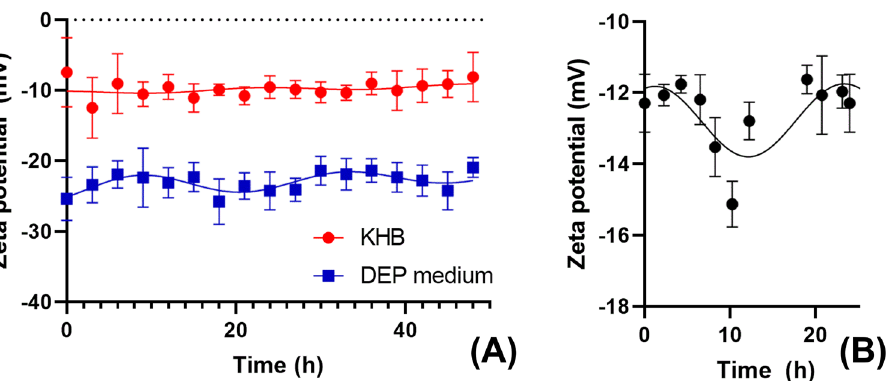
Figure 6. Circadian behaviour of ζ -potential in RBCs. ( A ) mean (n = 4) ζ for RBCs entrained and suspended in KHB and DEP medium, together with best-fit rhythm with period of 24.5 h and 24.3 h respectively. ( B ) ζ of RBCs taken directly from a participant over a 24 h period, measured within 60 s of donation, together with a best-fit rhythm with 22.2 h period (time 0 h corresponds to